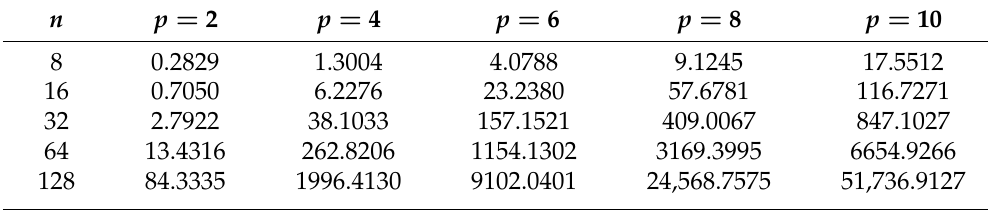
Table A1. Execution time (ms) of PDIST . Setup operation on desktop PC.